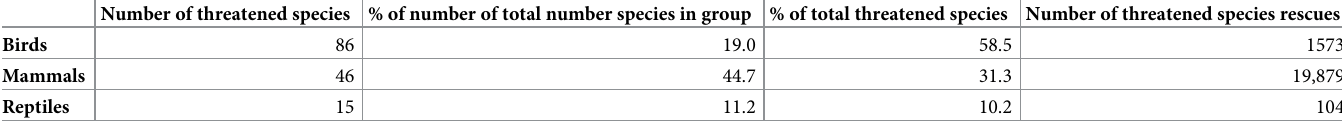
Table 5. Number of New South Wales threatened species per animal group, as a percent of total species in that group and of the total number of threatened species across all groups. Number of threatened species % of number of total number species in group % of total threatened species Number of threatened species rescues Birds